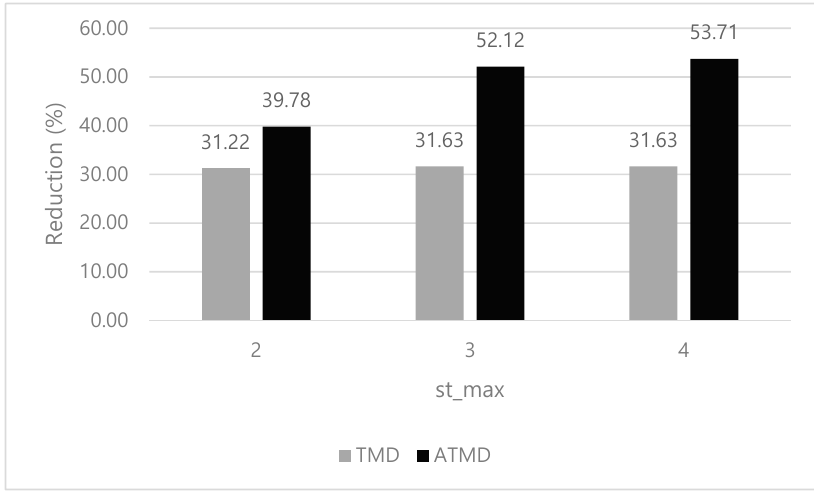
Figure 7. The reduction percentages for TMD and ATMD for st_max cases.